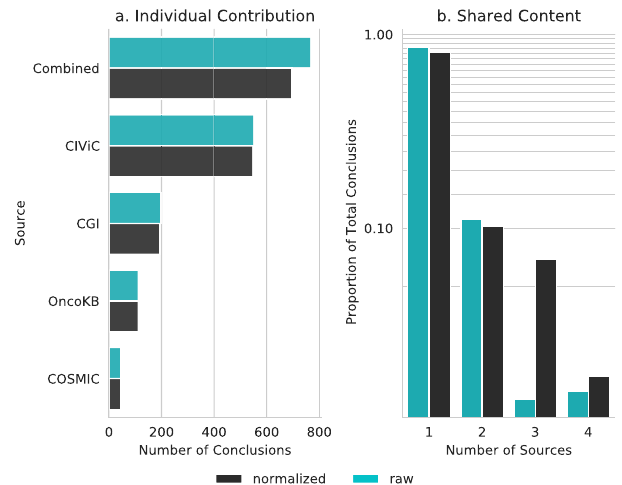
Fig. 4 Clinically informative conclusion agreement across knowledge bases. ( a ) The individual contribution of each source is shown as the number of unique conclusions which are given for both raw and normalized counts. The raw values represent the number of conclusions prior to normalization. ( b ) The amount of content which is shared between sources is shown as a fraction of the total number of unique conclusions. Source data are provided as a Source Data fi